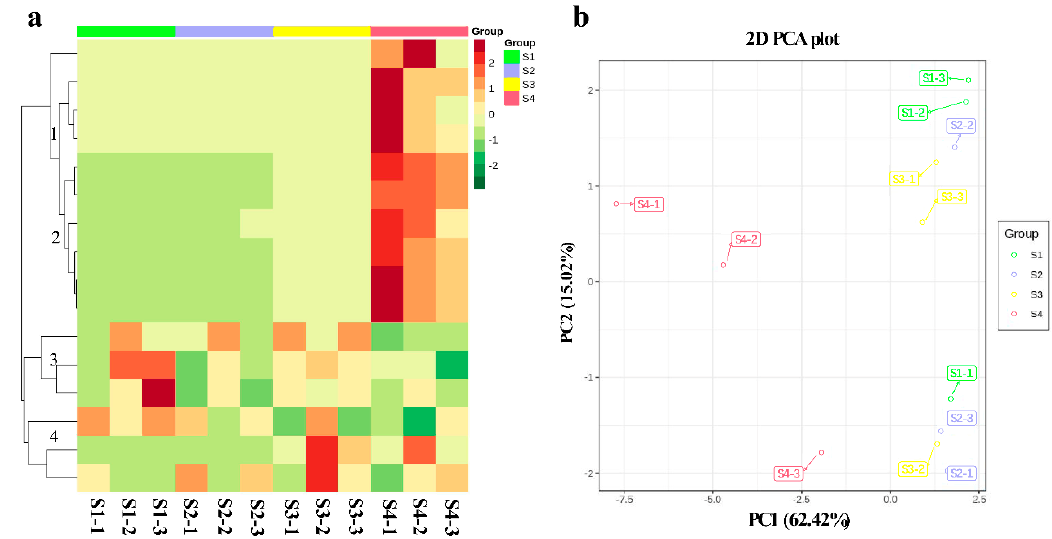
Figure 2. Heat map and PCA of the relative differences in anthocyanins in different fruit development stages in Cerasus humilis fruit peel; ( a ) Heat map visualization. Each sample is visualized in a single column, and each metabolite is repre- sented by a single row. Red indicates high abundance and green indicates low abundance; ( b ) Score plots for PCA. Young fruit (S1), 30 days after flowering, green fruit (S2), 42 days after flowering, slightly red fruit (S3), 57 days after flowering, and red fruit (S4), 70 days after flowering. Metabolite names are listed in Table S1.